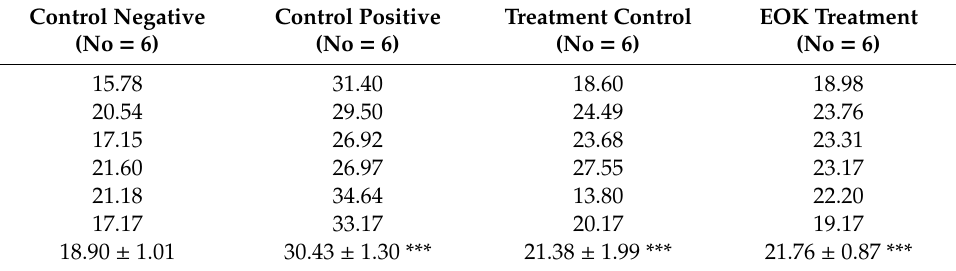
Figure 3. Variations in periodontal ligament thickness across the different groups: ( A ) control negative group, ( B ) control positive group, ( C ) treatment control group, ( D ) EOK treatment group, (H&E, scale bar 10 μm). Table 3. Analysis results for PDL thickness in each of the study groups.